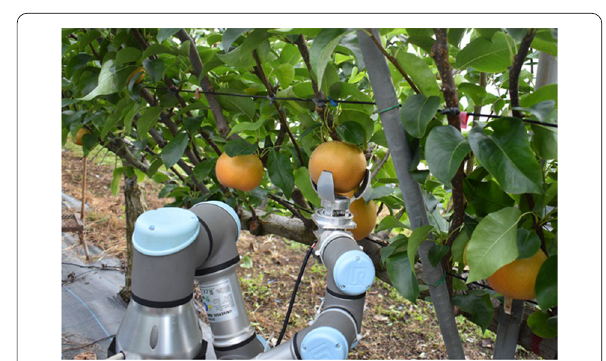
Fig. 2 Harvesting with an